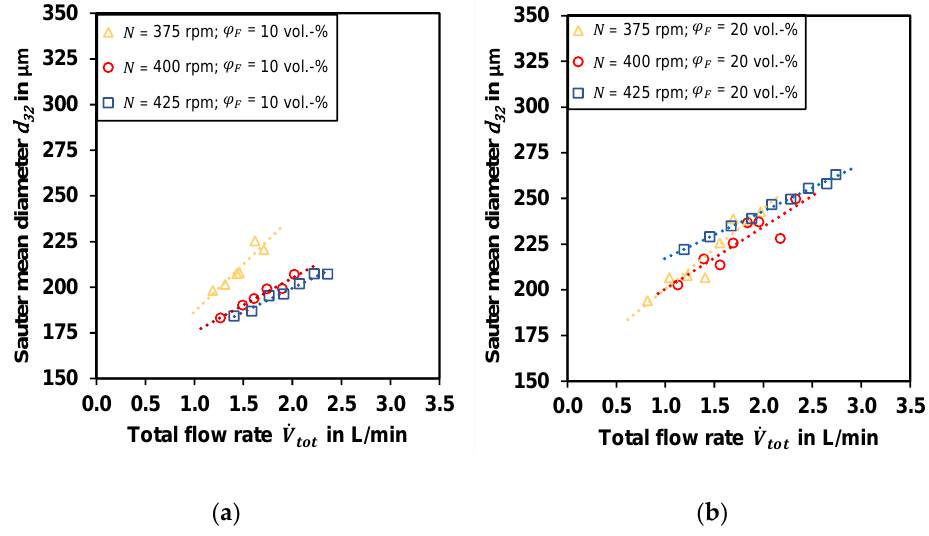
Figure 10. Sauter mean diameter at measurement position 𝑀𝑃 1 at a feed phase ratio of ( a ) 10 vol.-% and ( b ) 20 vol.-%. The dashed lines are least square lines as a guide for the eye.